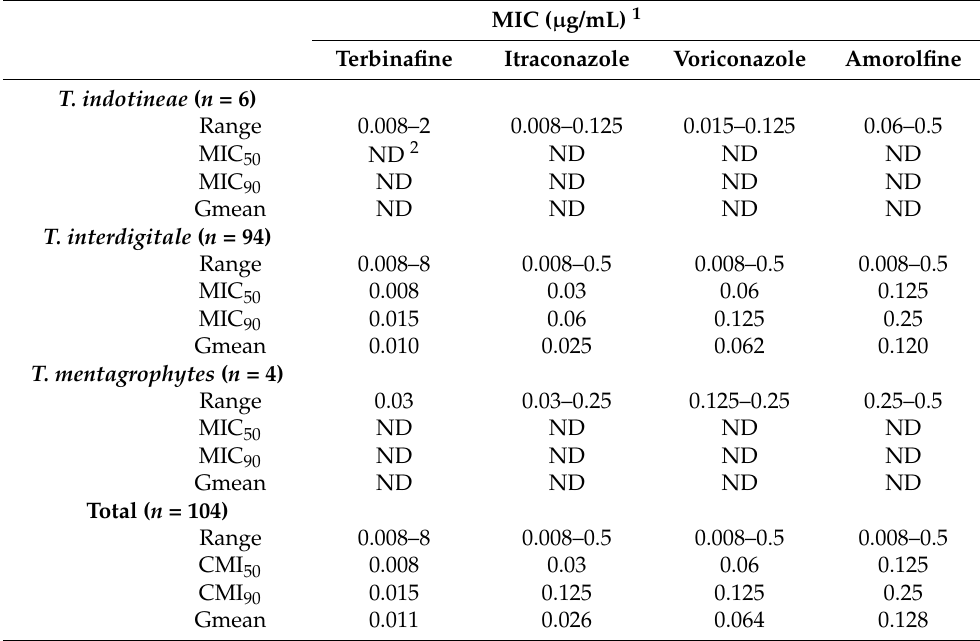
Table 3. MICs values of 4 antifungal agents for 104 clinical isolates of T. indotineae , T. interdigitale and T. mentagrophytes collected in Paris area,